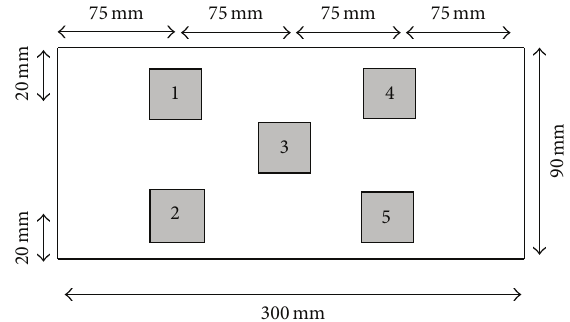
Figure 1: The rough mirror with five control patches. The surface roughness is assumed to be uniform across the